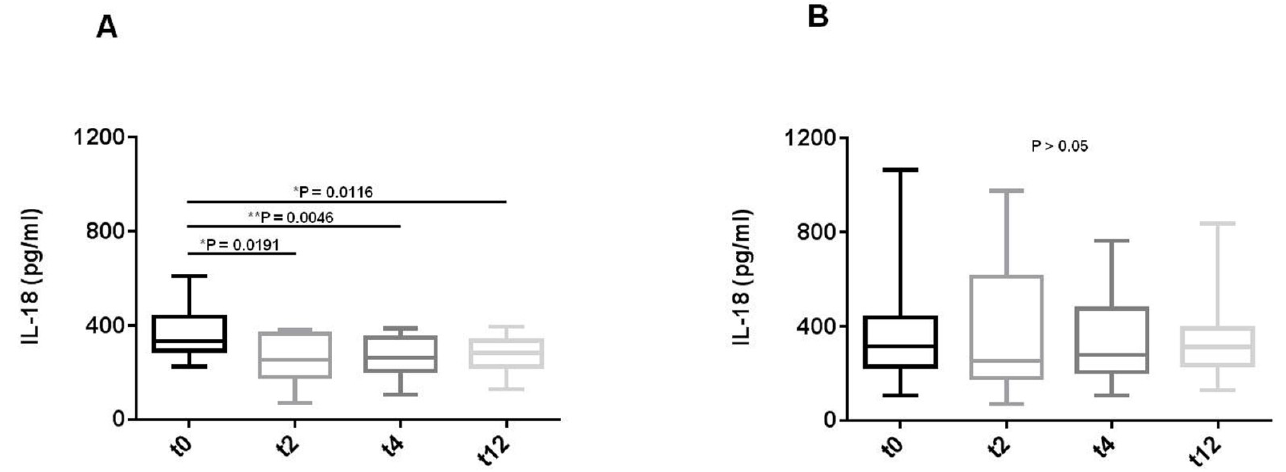
Figure 5. Belimumab reduces circulating IL-18 concentrations evaluated in sera from SLE patients. IL-18 levels in sera and lysates from 26 SLE patients were assessed using a commercially available ELISA kit. Sera and lysates were collected at baseline (t0) and after 2, 4, and 12 weeks (t2, t4, and t12) of belimumab therapy. All of the samples were run in triplicate in three different assays, and the results are shown as the mean ± standard deviation (SD). ( A ) For systemic IL-18 concentrations in sera, * p = 0.0191 t0 vs. t2; ** p = 0.0046 t0 vs. t4; * p = 0.0116 t0 vs. t12. ( B ) For IL-18 expression levels analyzed in lysates, p > 0.05 for all the conditions.